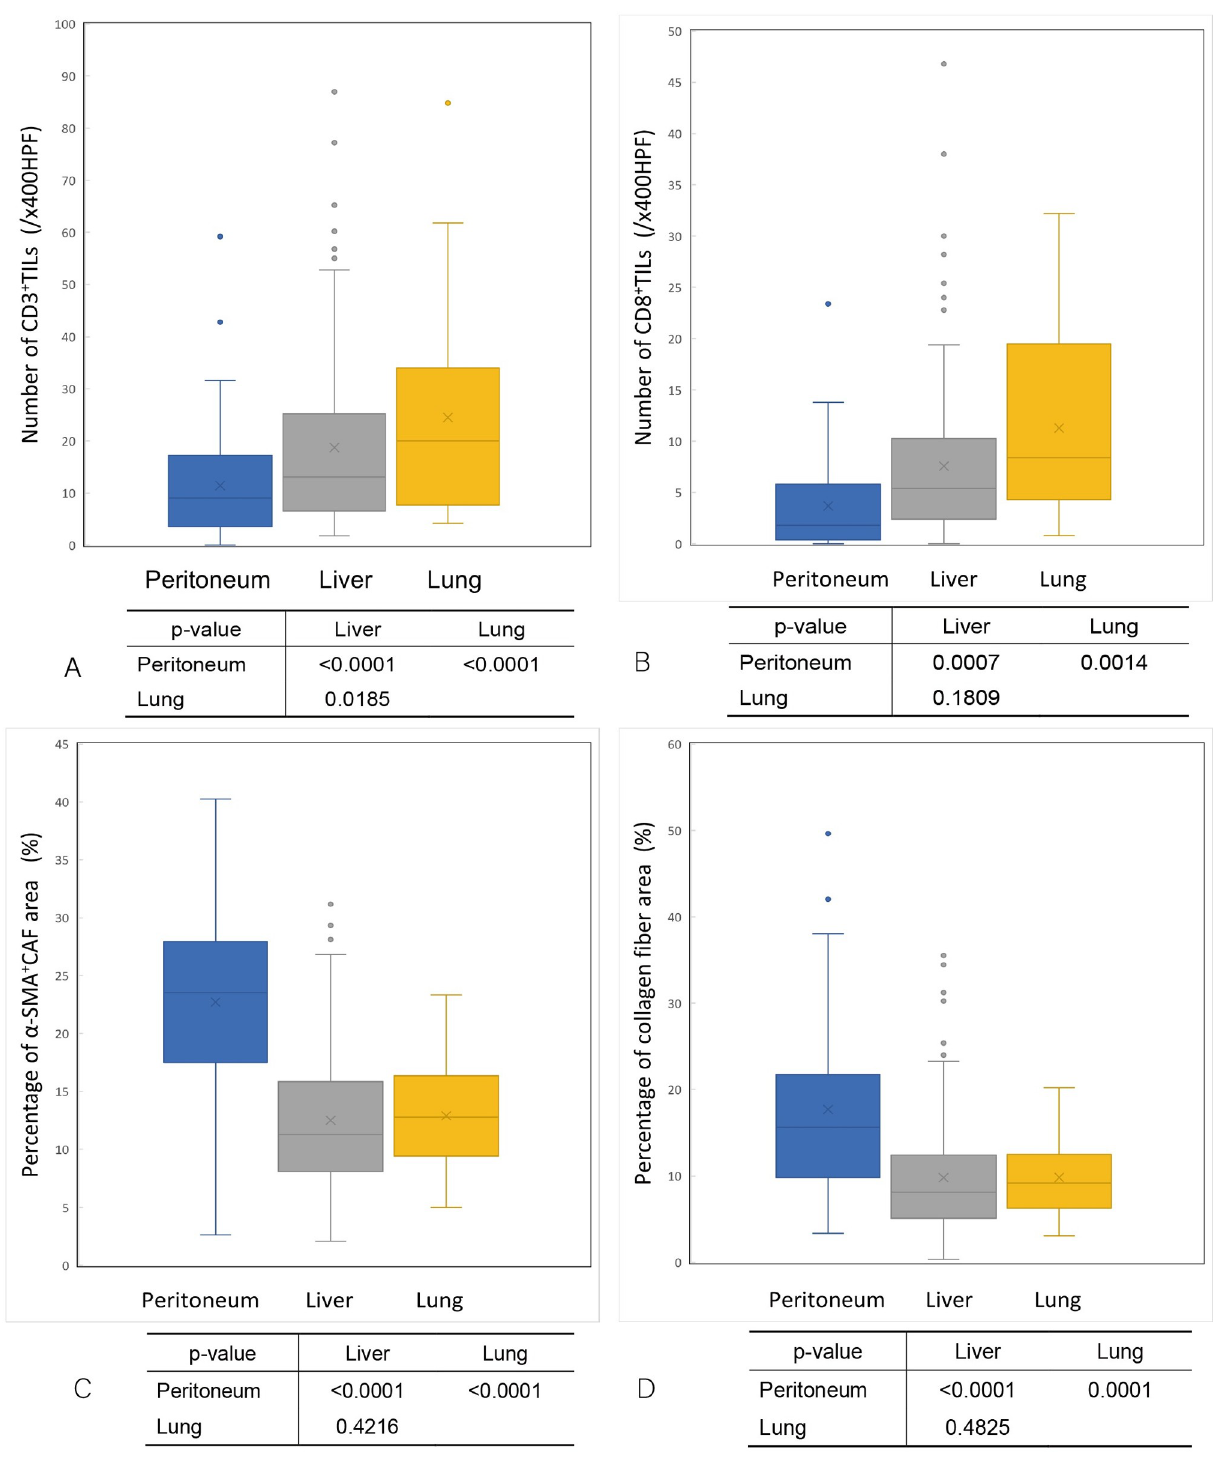
Fig 12. The comparison of the density of tumor-infiltrating lymphocytes and intratumoral fibrosis in each organ. (A) The density of CD3-positive tumor-infiltrating lymphocytes in peritoneal metastases was significantly lower than that in liver metastases (p < 0.0001) and lung metastases (p < 0.0001). (B) The density of CD8-positive tumor-infiltrating lymphocytes in peritoneal metastases was significantly lower than that in liver metastases (p = 0.0007) and lung metastases (p = 0.0014). (C) The ratio of the α -SMA-positive cancer-associated fibroblast area in peritoneal metastases was significantly greater than that in liver metastases (p < 0.0001)and lung metastases (p < 0.0001). (D) The ratio of the collagen fiber area in peritoneal metastases was significantly greater than that in liver metastases (p < 0.0001) and lung metastases (p = 0.0001). https://doi.org/10.1371/journal.pone.0255049.g012 PLOS ONE | https://doi.org/10.1371/journal.pone.0255049 July 22,